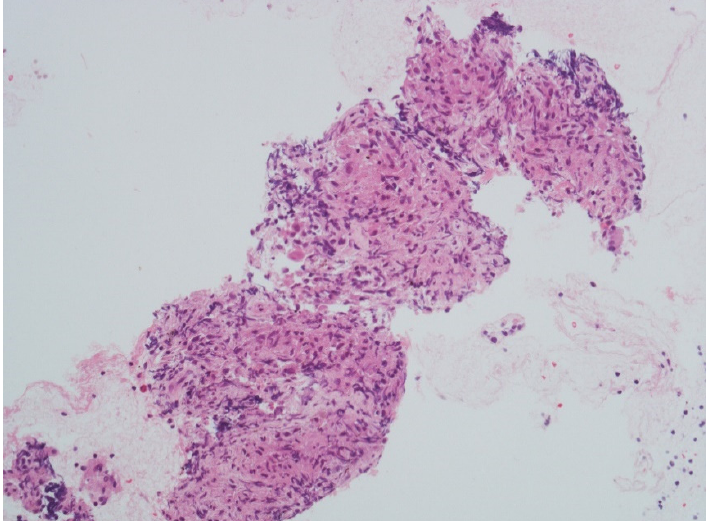
Figure 2. Parahilar lymph node biopsy showing epithelioid macrophages in granulomatous aggre- gation (courtesy of Professor R. Boldorini Division of Pathology, Department of Health Science, University of Piemonte Orientale (UPO), Novara, Italy) . Scale bar: 100 μ m (40× magnification).